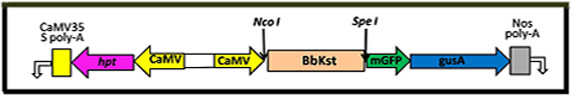
Construct map of JS1304. Full length cDNA was inserted in between NcoI and SpeI of the vector pCAMBIA 1304 containing GUS and GFP as selection marker.